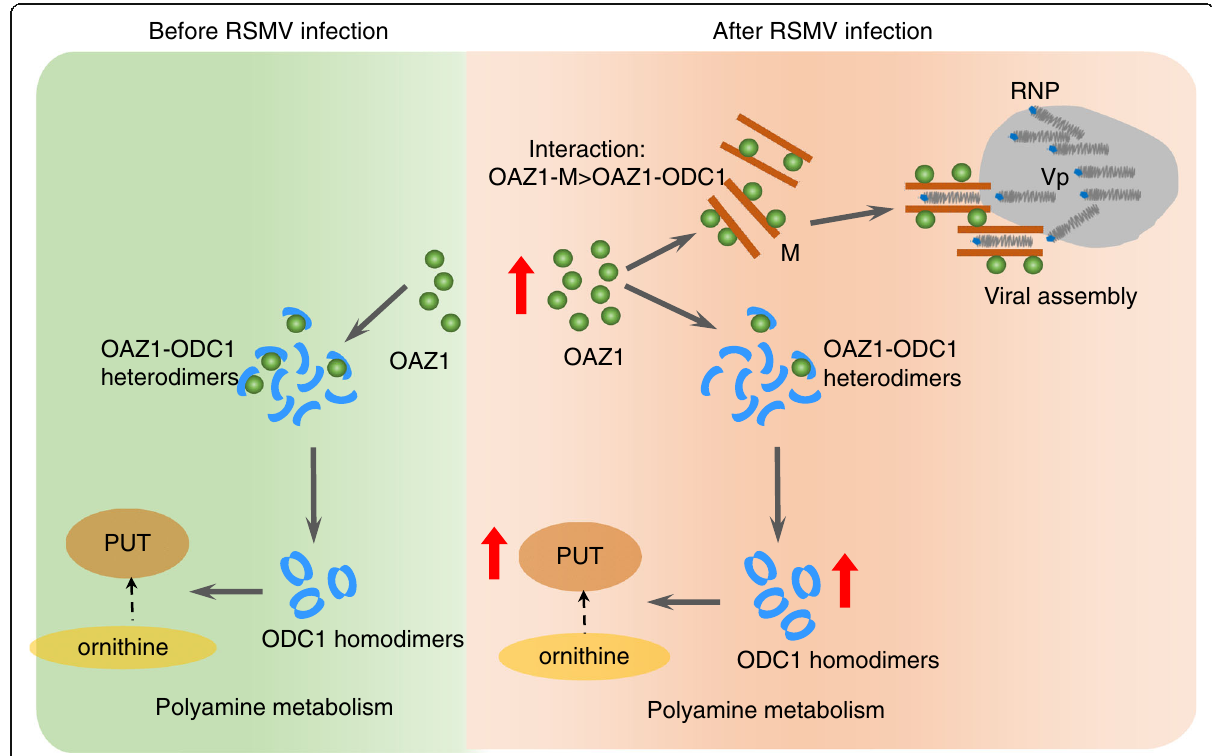
Fig. 6 The proposed model for the activation of OAZ1 by RSMV infection to promote polyamines production and viral assembly in insect vectors. In virus-infected cells, the elevated OAZ1 contents are mostly recruited by RSMV M to promote viral assembly at the periphery of viroplasm. This process decreases the ability for OAZ1 to target and mediate the degradation of ODC1, finally leading to the increase of ODC1 contents to promote the conversion of ornithine to Put. RNP, ribonucleoprotein; M, matrix protein; Vp, viroplasm; PUT,